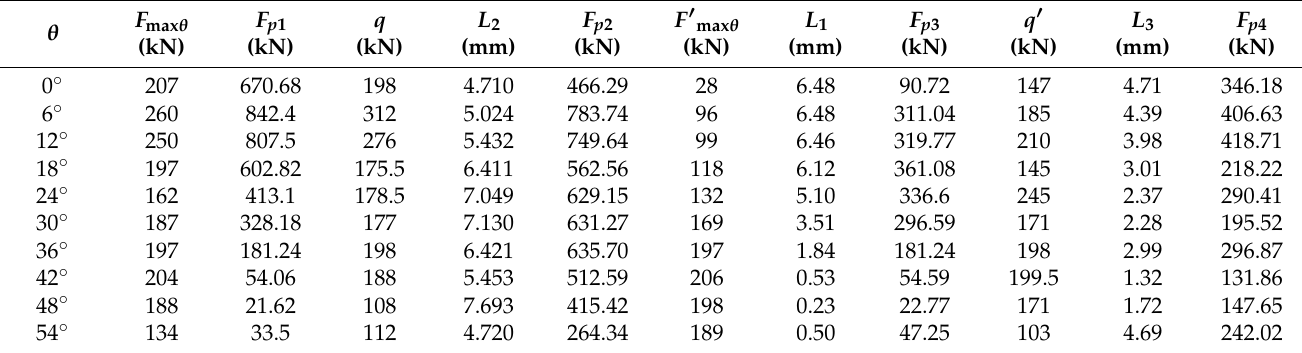
Table A1. Equivalent stress table of alternating fluid pressure on slide